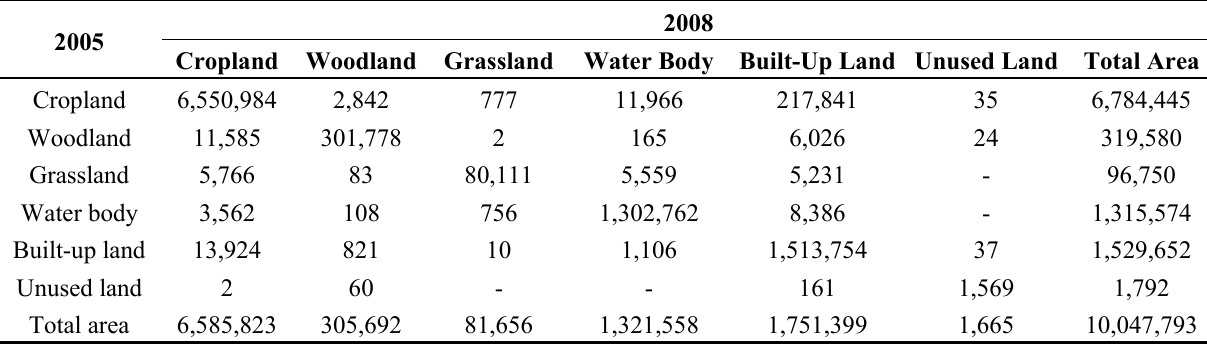
Table 3. Conversion matrix of land use from 2005 to 2008 (unit: ha).